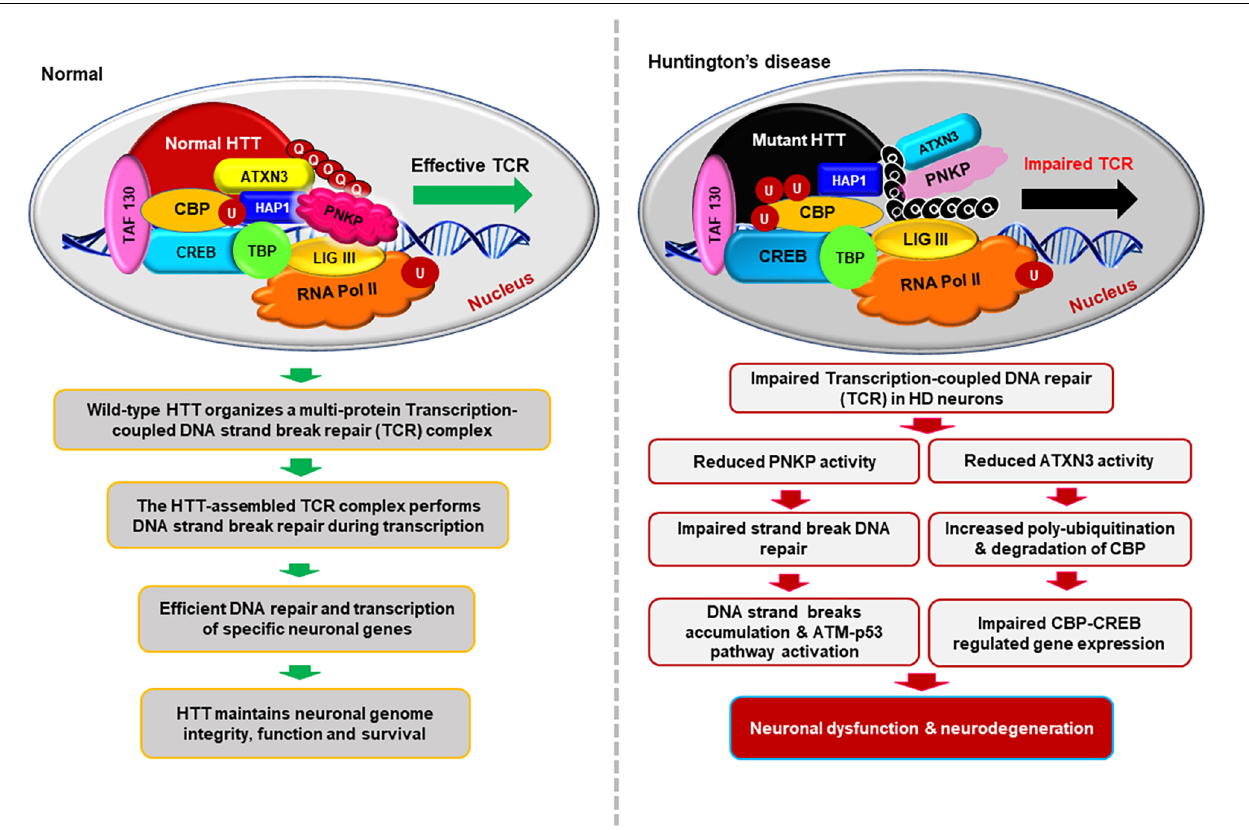
FIGURE 3 | Schematics illustrating how HTT helps to maintain neuronal genome integrity and how mHTT synchronously impairs DNA repair and transcription in HD. This hypothesized multi-protein transcription-coupled DNA repair (TCR) complex assembled by HTT senses DNA strand breaks/lesions during transcription elongation and orchestrates their faithful repair to maintain the sequence integrity of neuronal genome. HTT thus plays a pivotal role in maintaining neuronal health, function, and survival. This novel complex thus provides an additional layer of protective mechanism to strictly maintain the sequence integrity of the transcriptionally active region of genome to protect the protein-coding regions of neuronal genome. By contrast, the presence of mHTT in the TCR complex impairs the activity of the complex, resulting in persistent accumulation of DNA lesions/damages in neuronal genome. Persistence of DNA strand breaks/lesions in genome can interfere with the translocation of transcribing RNA polymerase over the template DNA, impeding adequate transcription of many neuronal genes in HD. Inadequate expression of neuronal genes, may adversely impact neuronal health, neurotransmission, calcium homeostasis, and synaptic function, causing early neurotoxicity in HD. Additionally, persistence of unresolved DNA damage in neuronal genome may also result in chronic activation of the DNA damage-response (DDR) ATM-p53-dependent pro-apoptotic signaling pathways facilitating premature demise of neurons in HD. Moreover, mHTT also can inactivate ATXN3’s deubiquitinating activity, facilitating poly-ubiquitination and subsequent degradation of cyclic AMP-response element-binding protein (CBP), impairing CBP-CREB-regulated gene transcription, further amplifying the pro-degenerative output in the HD neurons.